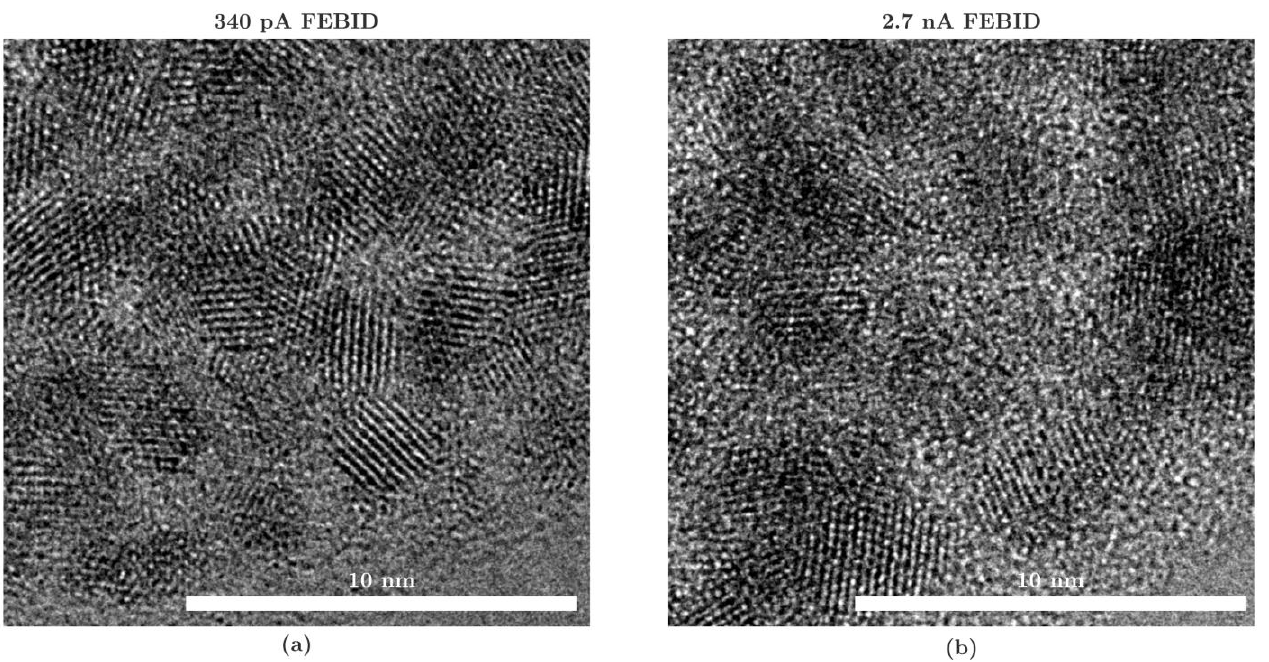
Figure 8. Comparison of the microstructure of ( a ) 340 pA and ( b ) 2.7 nA FEBID PtC. HRTEM images show the edge area of PtC nanotips captured by a Thermo Fisher Titan3. The 340 pA PtC shows smaller grains and higher density of the particles, then the 2.7 nA PtC with larger DLC areas between them.